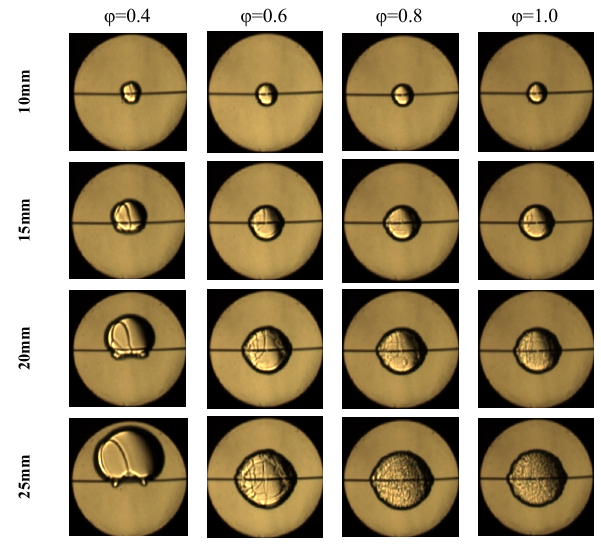
Figure 6. Schlieren pictures for flames of 30%H ratios for different radius.